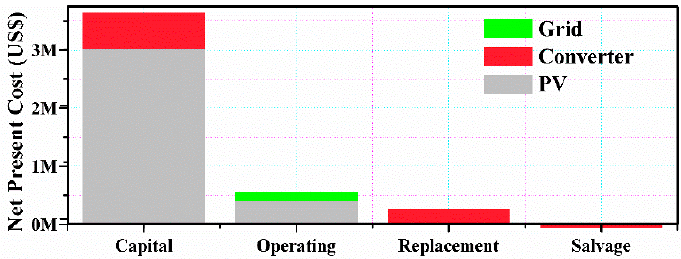
Figure 14. Net present cost (NPC) of scenario 5 with respect to components and cost type. Energies 2018 , 11 , x FOR PEER REVIEW